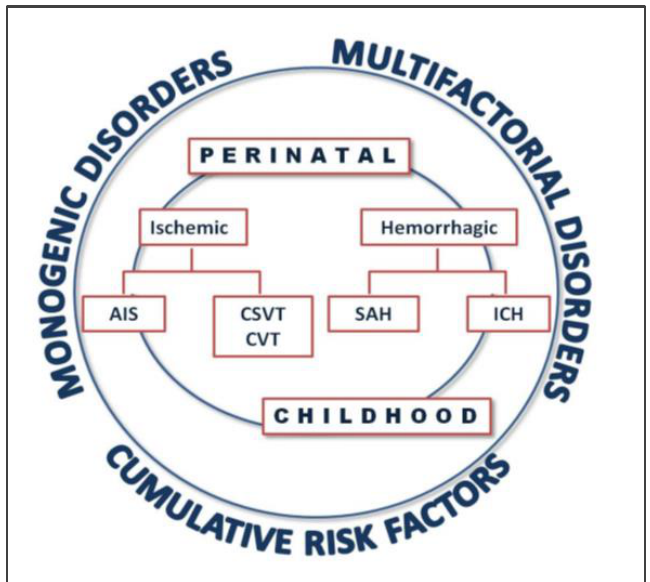
Figure 1. Schematic presentation of pediatric stroke causes. AIS, arterial ischemic stroke; CSVT, cerebral sinovenous thrombosis; CVT, cortical vein thrombosis; SAH, subarachnoid hemorrhage; ICH, intracerebral hemorrhage.